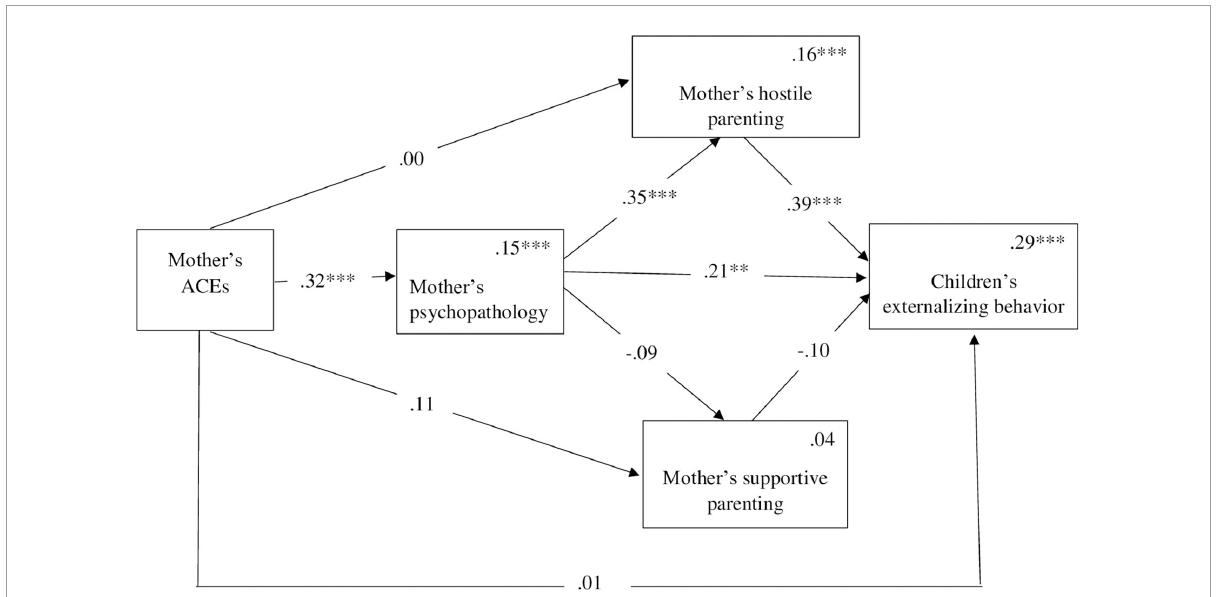
FIGURE3 Mediation model for the association between the mother’s ACEs externalizing behavior via the mother’s psychopathology and her hostile or supportive parenting. Numbers above the lines are standardized coefficients. Numbers in the upper right-hand corner in the rectangles present R 2 . While not presented in the figure, the child’s age and gender were included as covariates in the model. ∗∗ p < 0.01, ∗∗∗ p <